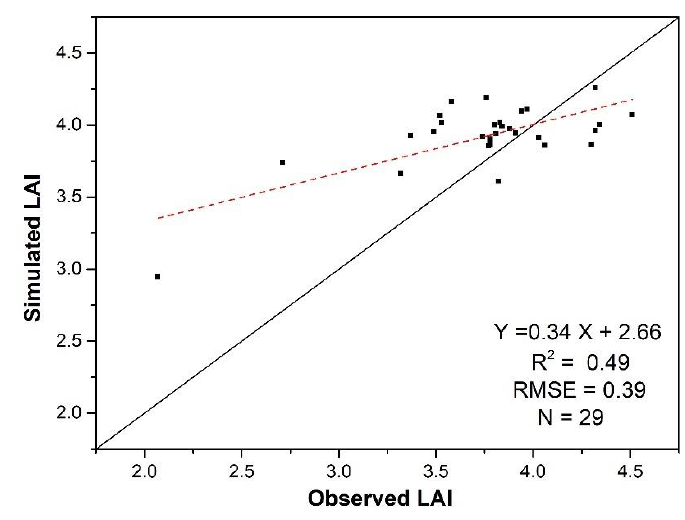
Figure 10. The LAI estimation accuracies for 25 August using the hybrid method.